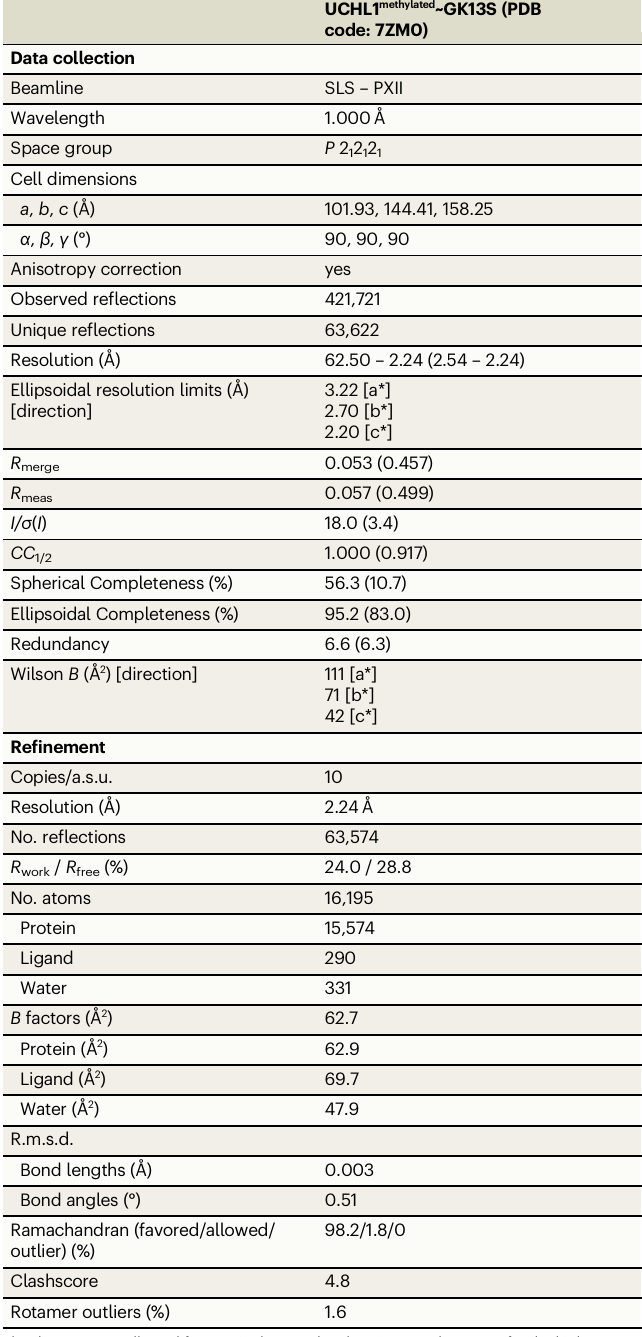
Table 1 | Data collection and re fi nement